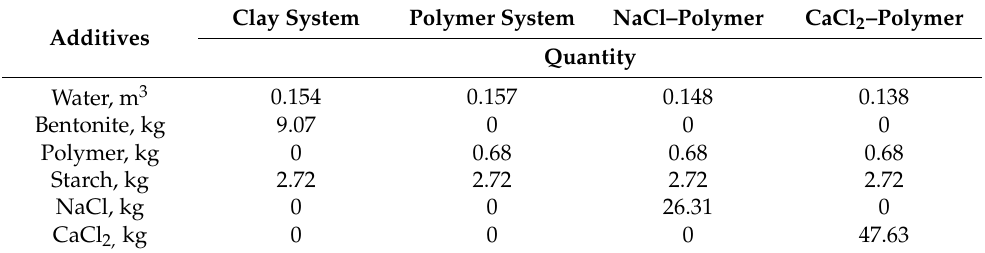
Table 2. Carrier fluid formulations.